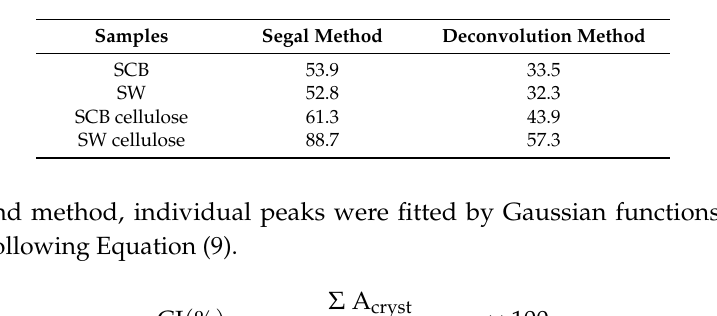
Figure 2. XRD analysis of untreated SCB, untreated SW, SCB cellulose, and SW cellulose. Table 2. Crystallinity index of u SCB, SW, SCB cellulose and SW